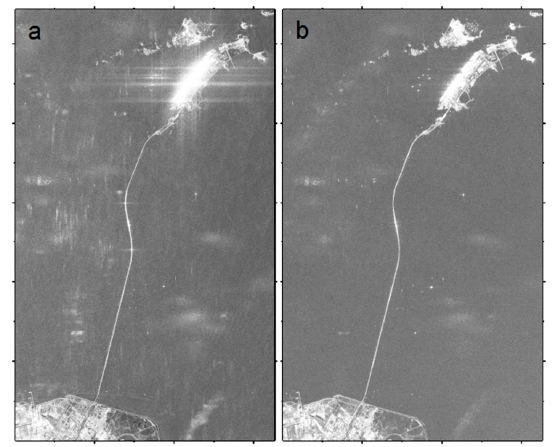
Figure 2. The amplitude image of Donghai Bridge from ( a ) Phased Array type L-band Synthetic Aperture Radar (PALSAR) HH polarization data, and ( b ) PALSAR HV polarization data. The figure is plotted in the synthetic aperture radar (SAR) coordinate system. Table 1. Image pairs used for monitoring of Donghai Bridge. B_perp and B_temp represent the perpendicular baseline and time interval between the two acquisitions, respectively. Master